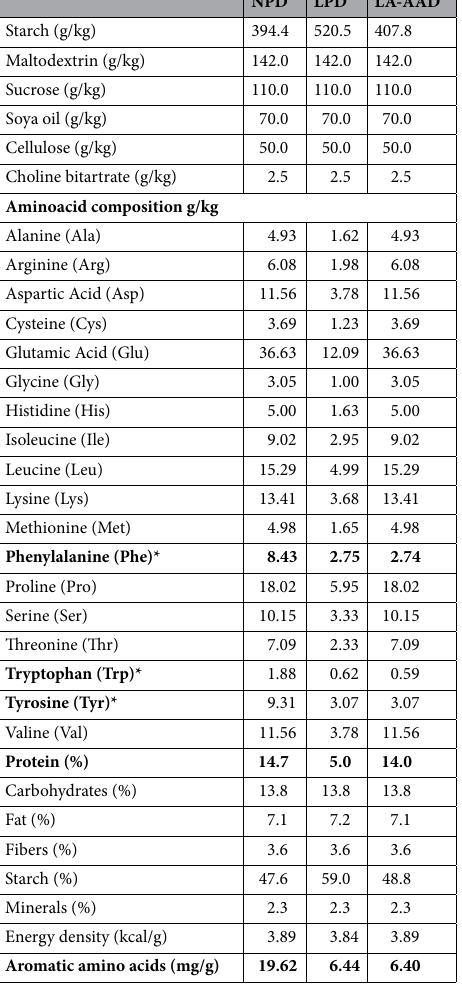
Table 1. Food composition and energy value of the different diets. Data are expressed as percentage for food composition and kcal/g for energy value. NPD Normoproteic diet, LPD Low protein diet, LA-AAD Low aromatic amino-acid diet. *Aromatic amino acids including tyrosine, tryptophan and phenylalanine are displayed in bold. Note that the low aromatic AA diet concentration of aromatic amino acids was similar to that low protein